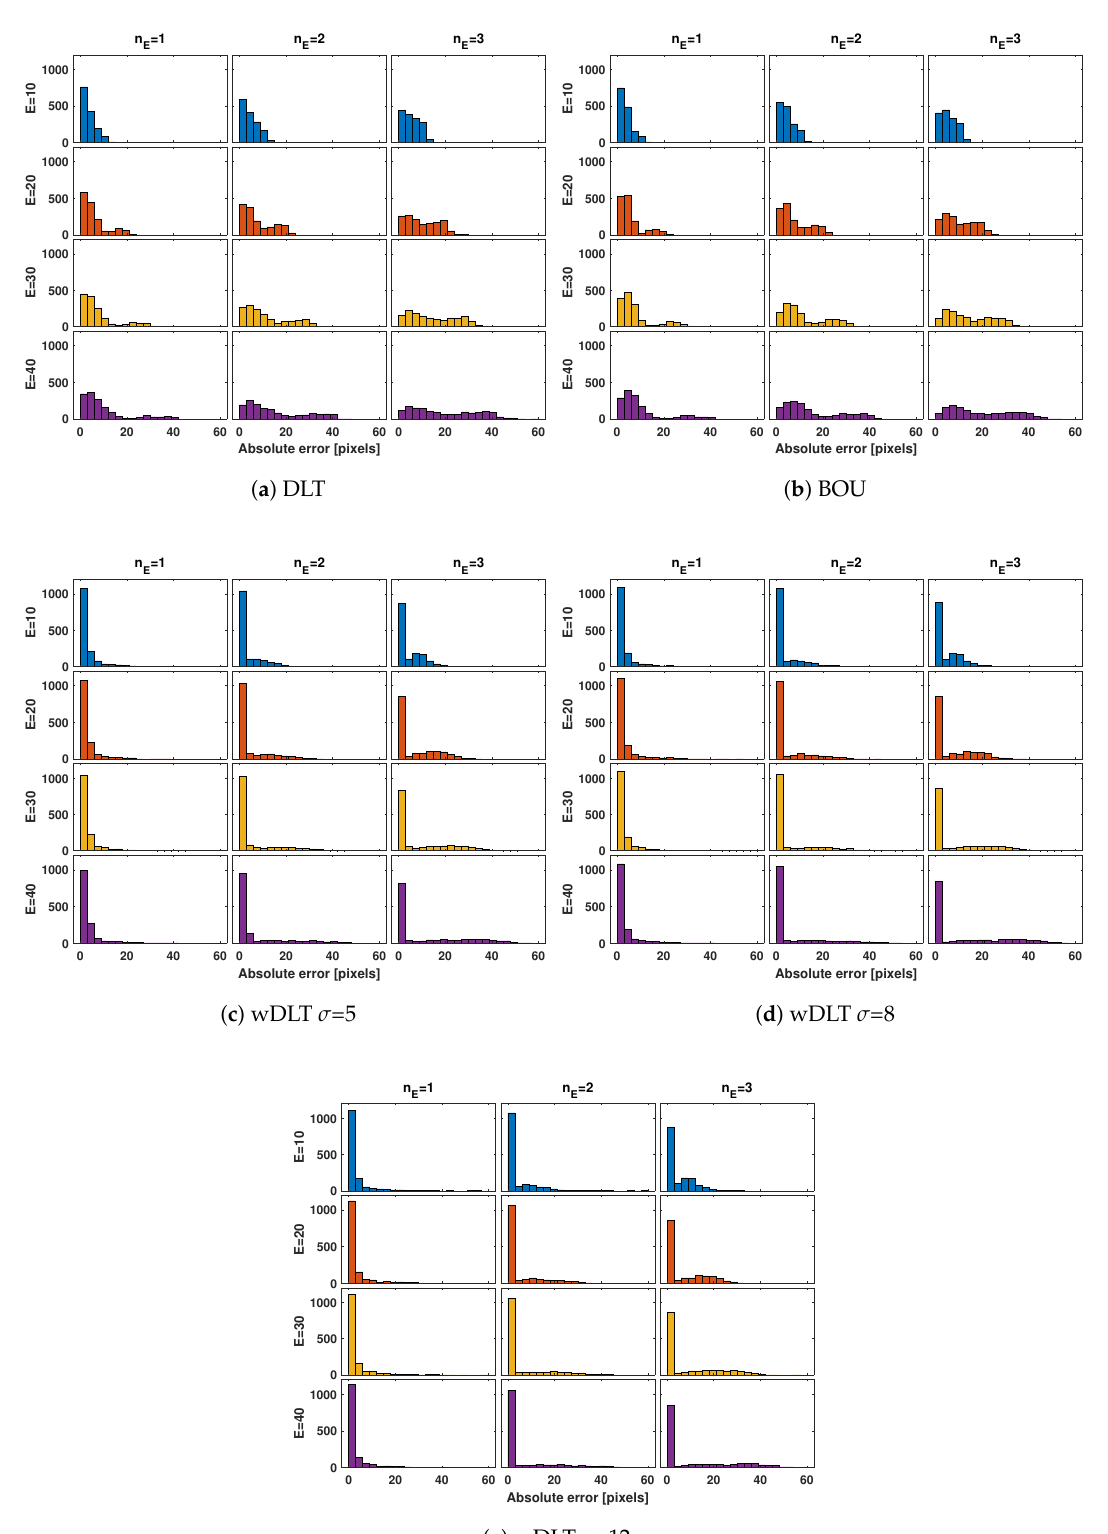
Figure A1. Distribution of the reprojection error of the calibration with DLT, BOU, and wDLT with n E perturbed control points and error